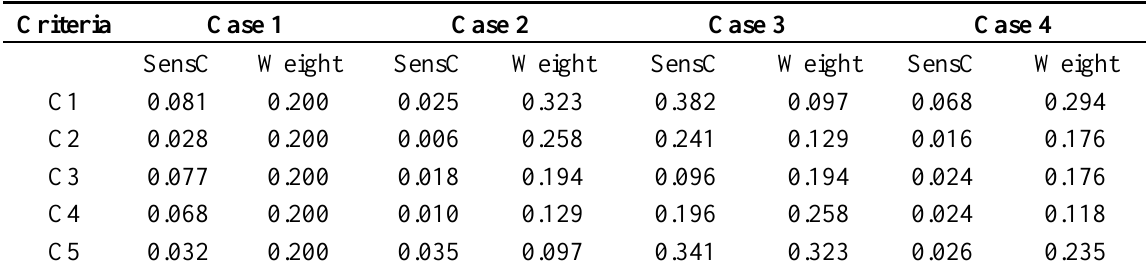
Table 5. Sensitivity coefficient and weight for criteria for the four